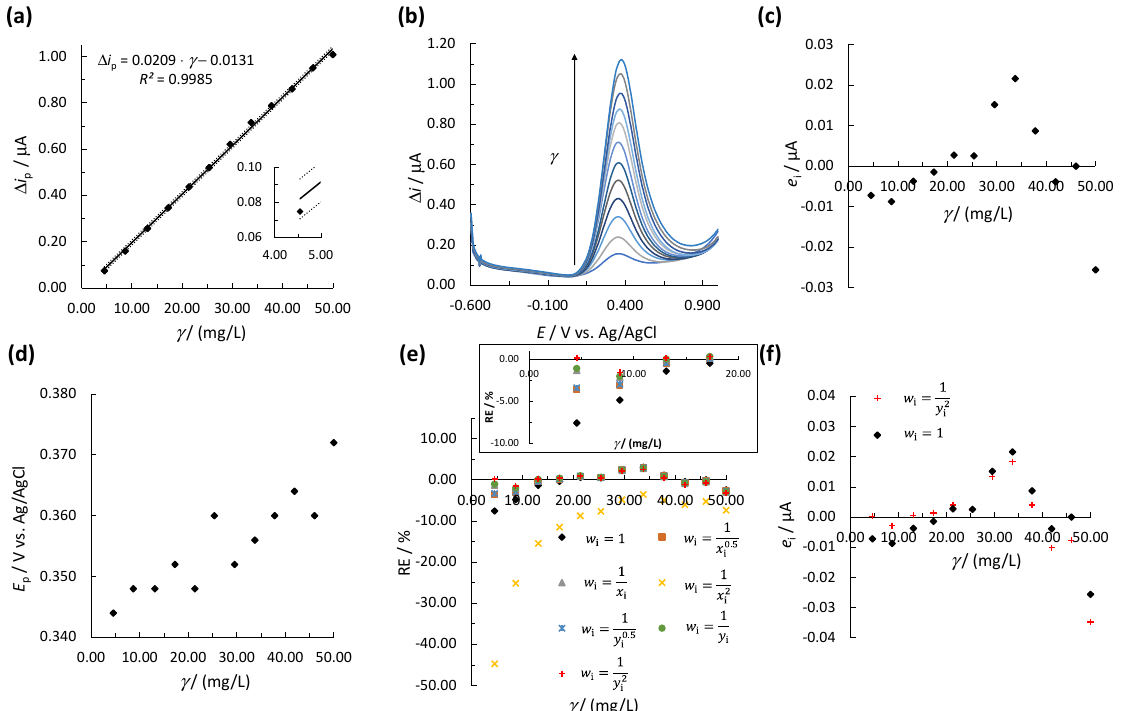
Figure 3. ( a ) The linear calibration curve for UA using the OLS method, where the solid line represents the calibration curve and the dotted lines represent the upper and lower 95% confidence intervals. The insert in ( a ) shows the first calibration point; ( b ) the SWV measurements for constructing the calibration curve; ( c ) the residual analysis, i.e., the plot of e i vs. γ , ( d ) the change in E p vs. γ , ( e ) %RE vs. γ for the unweighted and weighted models in Table 1 (the insert in ( e ) shows RE at lower concentrations); ( f ) the values of e i vs. γ for weighted model 7 and unweighted model 1. The measurements were performed by SPCE.